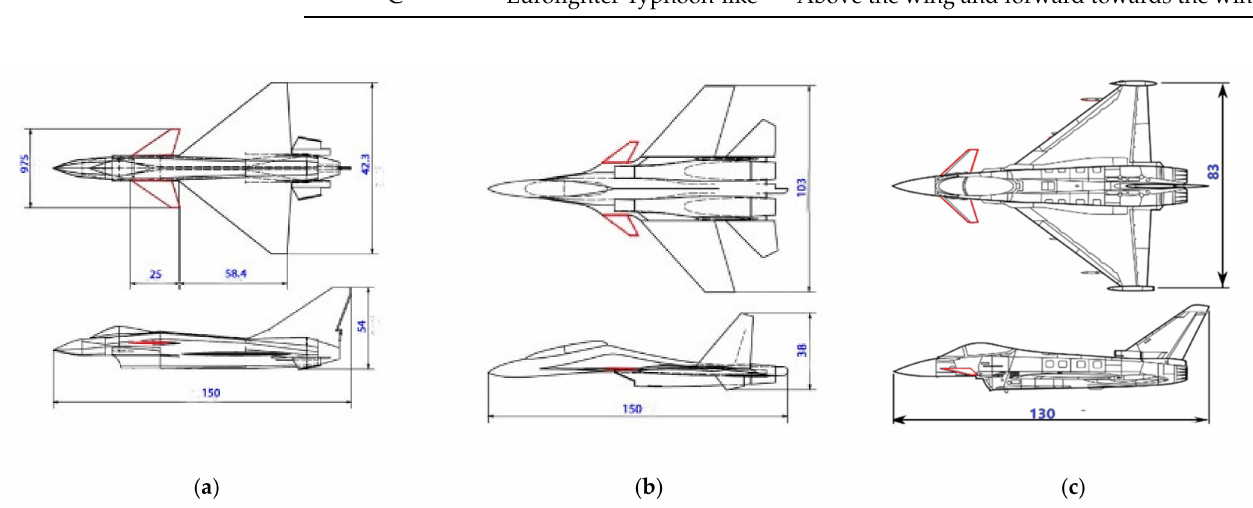
Figure 1. Geometry specimens of fighter aircraft models ( a ) J-10; ( b ) SU-30; ( c )